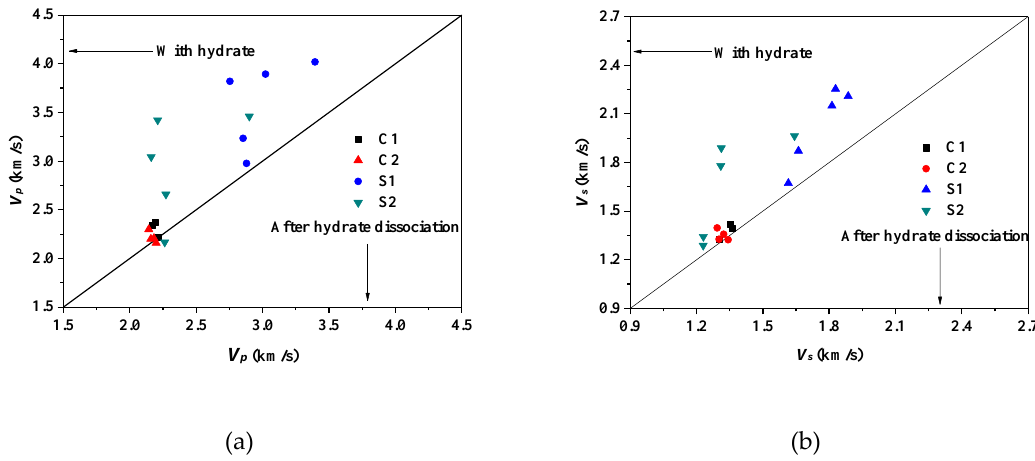
Figure 6. Comparison of the acoustic velocities of hydrate-bearing sediments before and after hydrate dissociation. ( a ) P-wave velocity, ( b ) S-wave velocity. Hydrate saturations are shown in Table